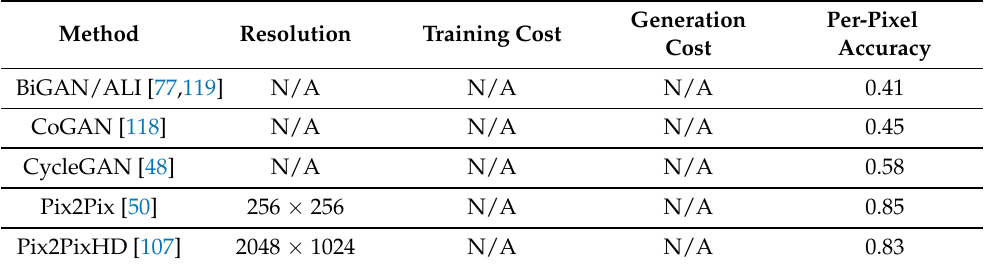
Table 4. Performance of different data synthesis methods for image segmentation against the Cityscapes photos to labels dataset, the higher the per-pixel accuracy, the